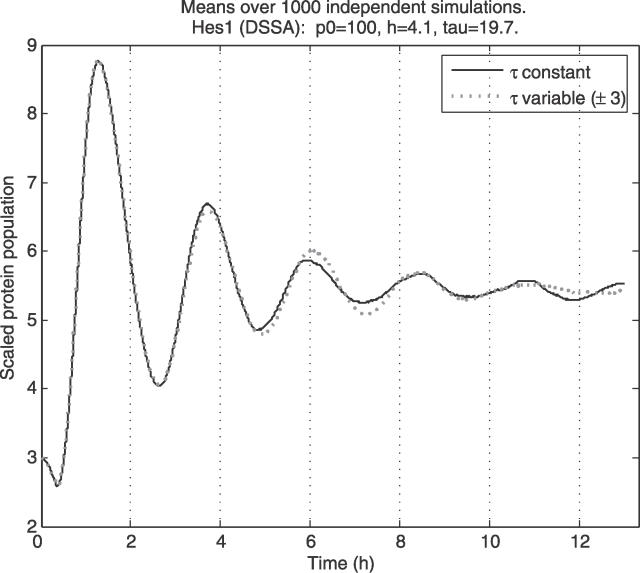
DSSA Simulation: Calculating the Arithmetic Mean over 1,000 Simulations for Both Constant and Variable Delay